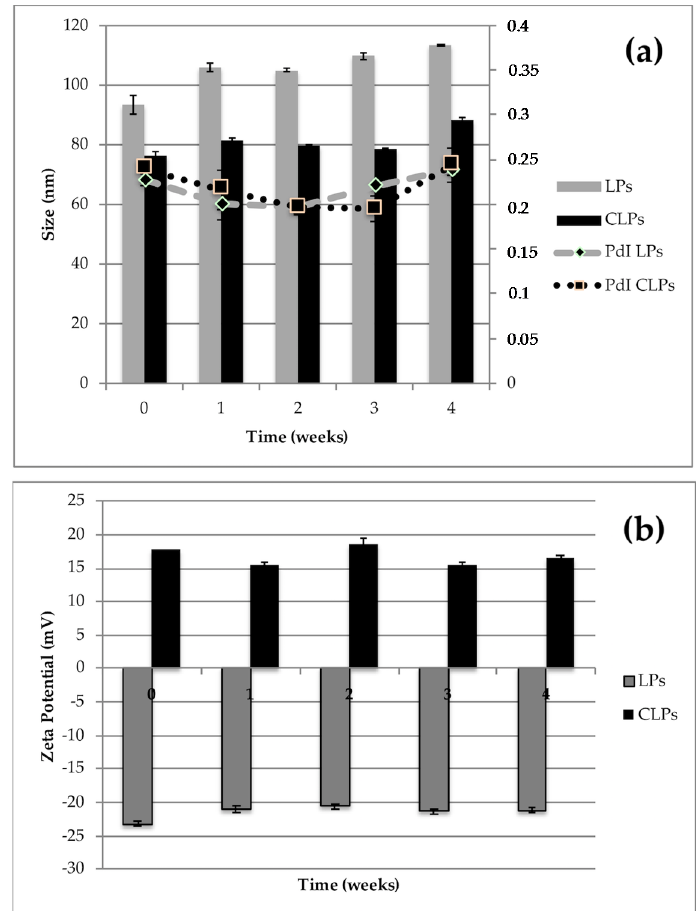
Figure 2. Particle size, polydispersity index (PdI) ( a ) and zeta-potential ( b ) of LPs-AG and CLPs-AG as dispersion after one-month storage at 4 °C. (Data displayed as mean ± SD; n = 3).